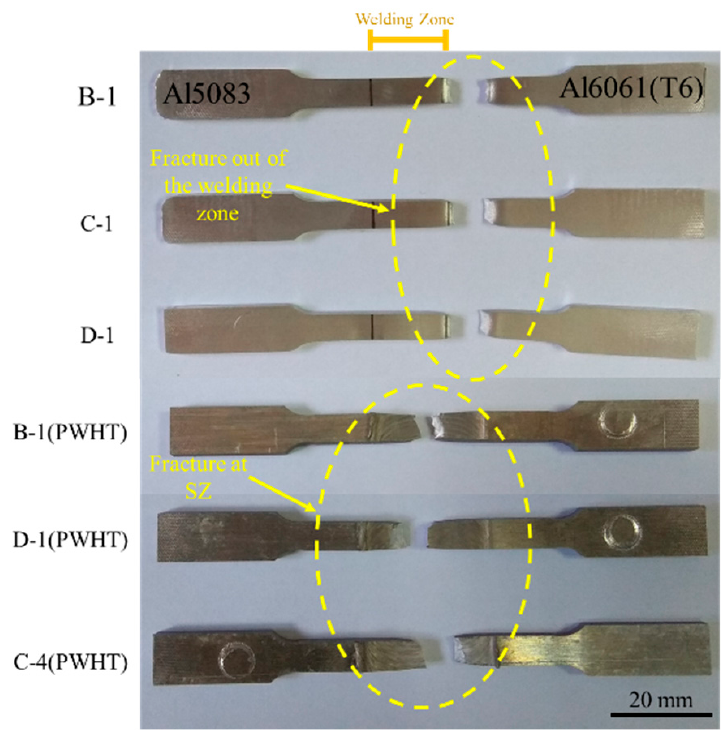
Figure 7. Fracture location of the dissimilar joint of Al5083-Al6061(T6) after the tensile test.